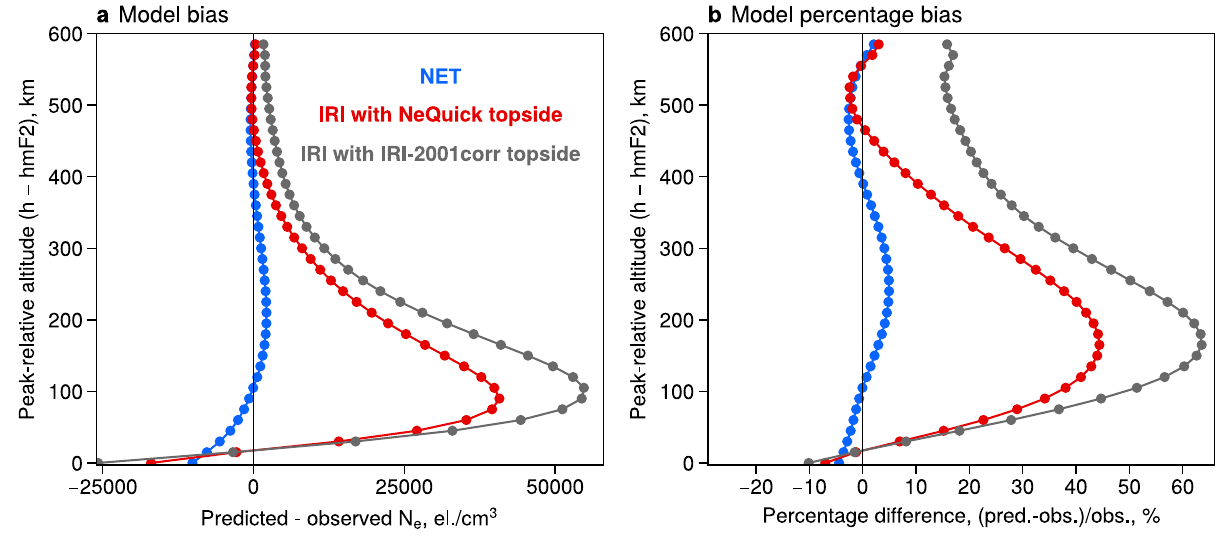
Figure 4. Median bias ( a ) and median percentage bias ( b ) versus altitude relative to the F2-peak, calculated on the test set of the COSMIC data. Biases of the developed NET model are plotted in blue. Vertical residuals of the IRI-2016 model are shown in red for the NeQuick topside option, and in grey for the IRI-2001corr topside